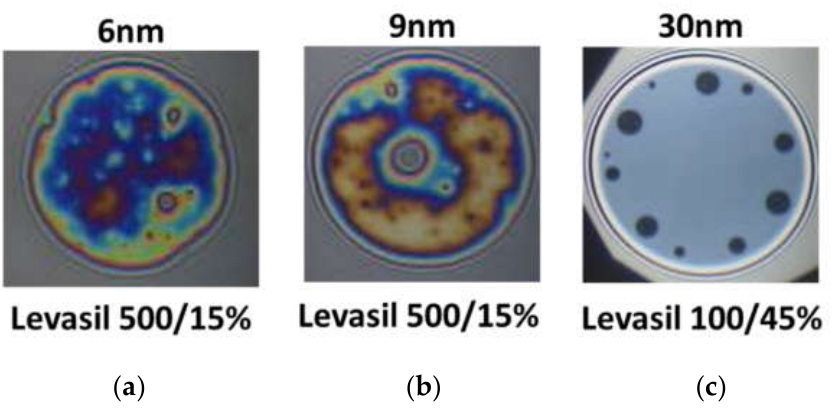
Figure 6. Snapshots of thin liquid foam films prepared from aqueous systems of chitosan 100 ppm, acetic acid 1%wt., lauroyl ethyl arginate LAE 100 ppm mixtures containing various kinds of Levasil ® . ( a ) 6 nm; ( b ) 9 nm; ( c ) 30 nm. The snapshots were obtained using Scheludko-Exerowa cell in thin liquid film instrumentation.